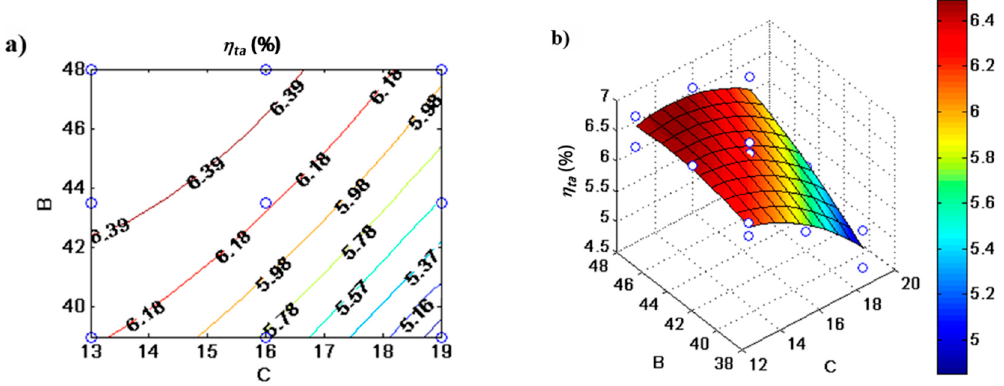
Figure 7. Contour plot ( a ) and 3D-response surface ( b ) of thermoacoustic e ffi ciency η ta at “Junction”, against the combined e ff ect of compliance and inertance inner diameters, B, and C, respectively.